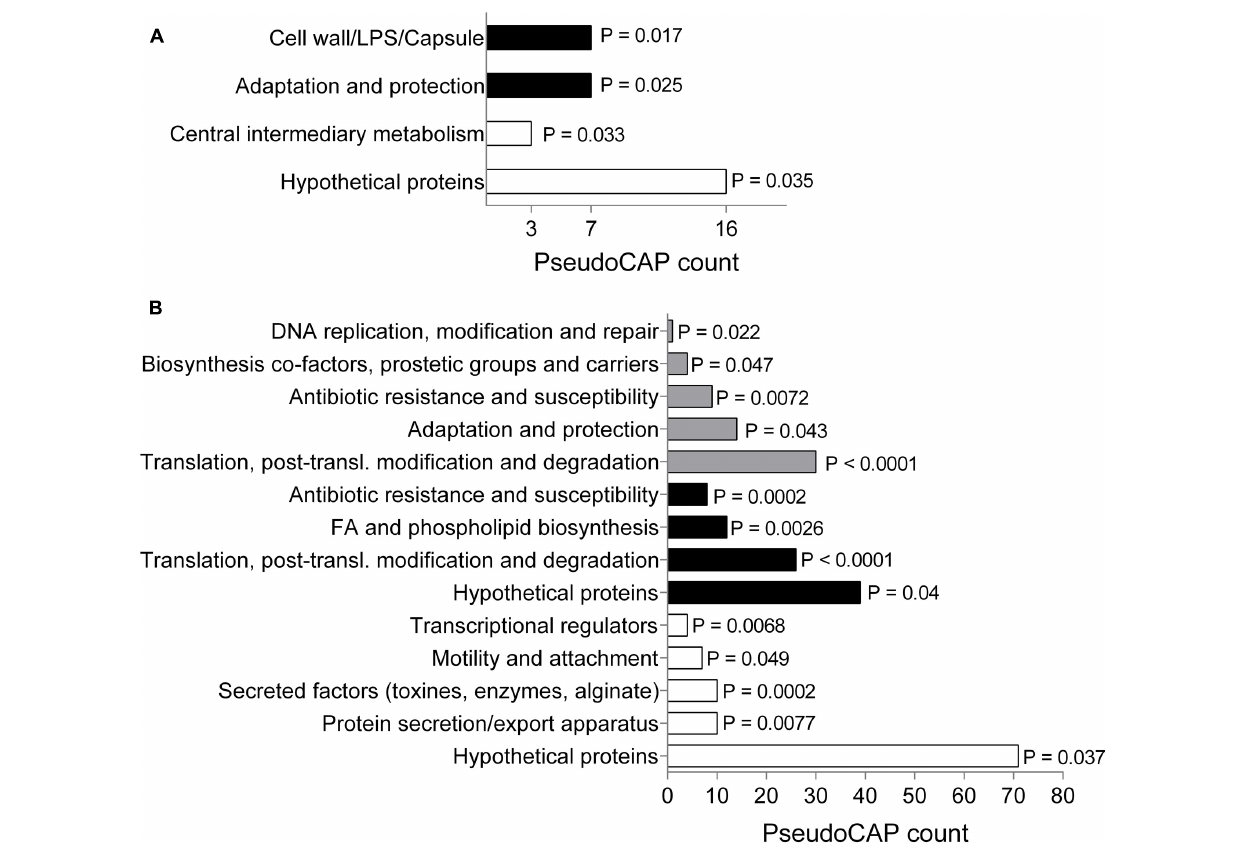
FIGURE 2 | Genetic analysis of SPI009 mode of action. (A) Functional enrichment of the obtained set of sensitive (black bars) and resistant (white bars) mutants using PseudoCAP classifications. P -values were determined using a two-tailed Fisher’s exact test ( α = 0.05). PseudoCAP counts represent the number of mutants in the respective classes. (B) Functional enrichment analysis of the up- and downregulated differentially expressed genes (log 2 fold change > 1) as determined after RNA sequencing upon treatment with SPI009. A two-tailed Fisher’s exact test was used to determine P -values for the classes of downregulated genes (white bars), upregulated genes (black bars), and the total set (gray